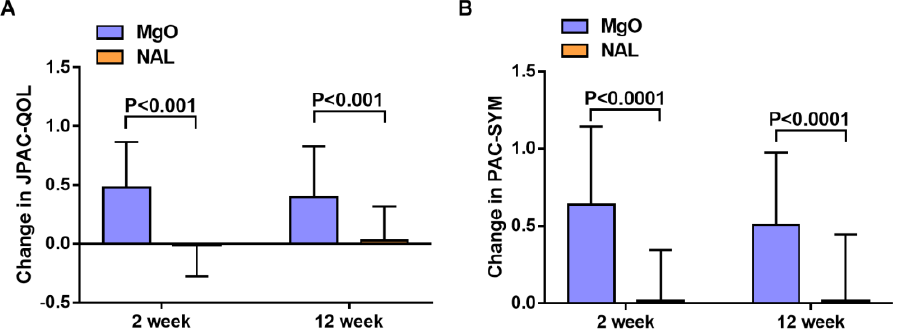
Figure 2. ( A ): Overall Japanese version of Patient Assessment of Constipation Quality of Life (JPAC- QOL) score at baseline and after 2 and 12 weeks of treatment in the magnesium oxide group and naldemedine groups; and ( B ) overall Patient Assessment of Symptoms (PAC-SYM) score at baseline and after 2 and 12 weeks of treatment in the magnesium oxide group and naldemedine